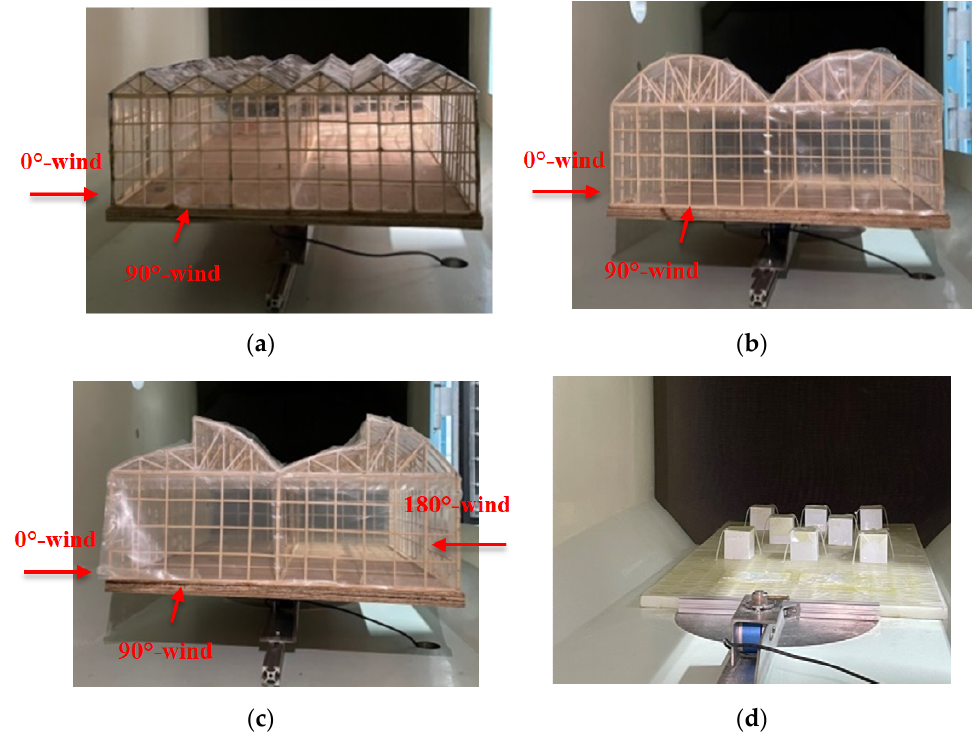
Figure 5. Experimental model for wind tunnel tests and simulation model for site type. ( a )Venlo Type ( b ) Round-arch Type ( c ) Saw-tooth Type ( d ) Simulate Terrain. Type ( b ) Round-arch Type ( c ) Saw-tooth Type ( d ) Simulate Terrain. Table 4. Sampling methods and data processing methods. Table 4. Sampling methods and data processing